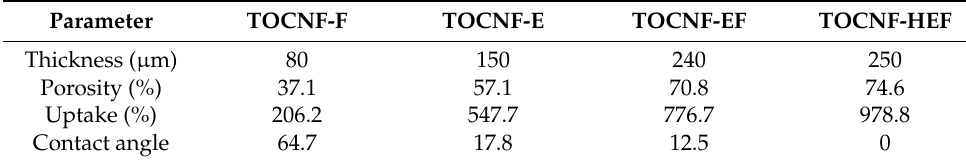
Table 1. Physical properties of four TOCNF separators at room temperature.